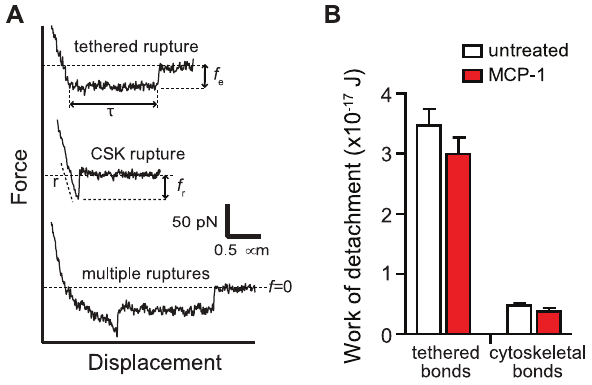
Figure 3. Single molecule measurements of the a 4 b 1 /VCAM-1 complex. (A) Representative force-distance curves were acquired during cantilever retraction ( , 3 m m/s) following a contact time of 100 ms. (Top Trace) Single tethered rupture event. Quantification of tether lifetimes ( t ) and extraction forces ( f e ) are depicted. (Middle Trace) Single cytoskeleton anchored rupture event. Loading rates ( r ) were determined from the linear slope of the force-distance curve immediately prior to the rupture, as indicated by the dashed line. Rupture force ( f r ) is determined from the peak of the rupture event to zero force (horizontal dash line). (Bottom Trace) Measurements exhibiting multiple ruptures. (B) Work of detachment (mean 6 s.e.m.) for single molecule adhesion of a cytoskeleton-anchored and mem- brane-tethered a 4 b 1 /VCAM-1 complex.